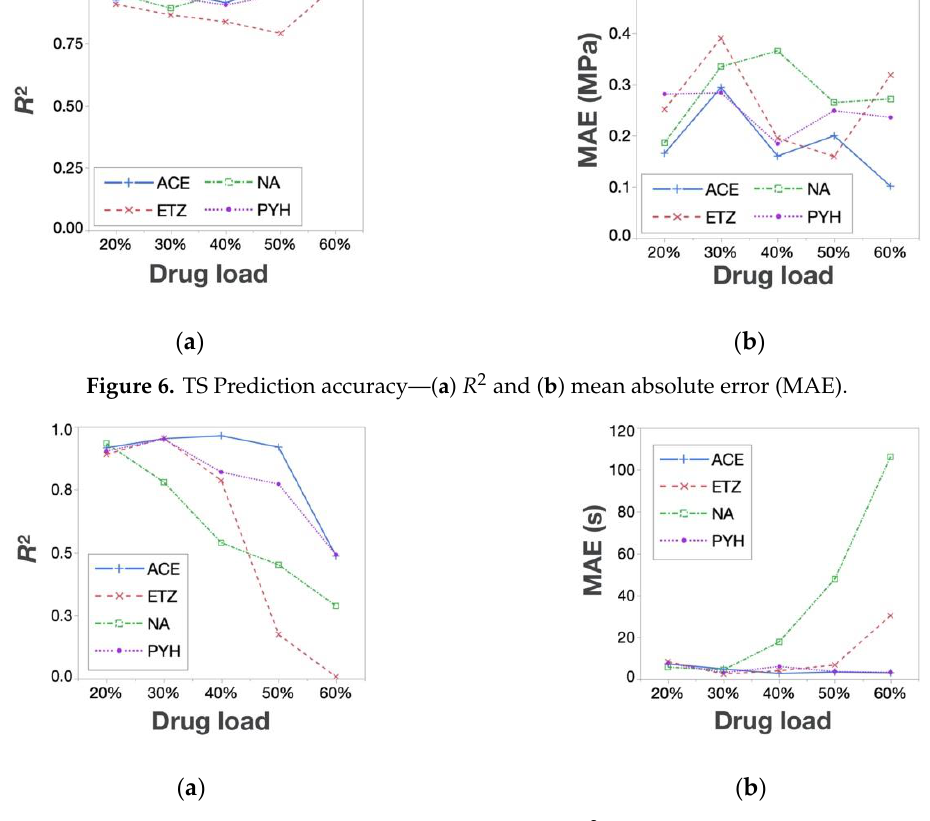
Figure 7. DT prediction accuracy—( a ) R 2 and ( b )